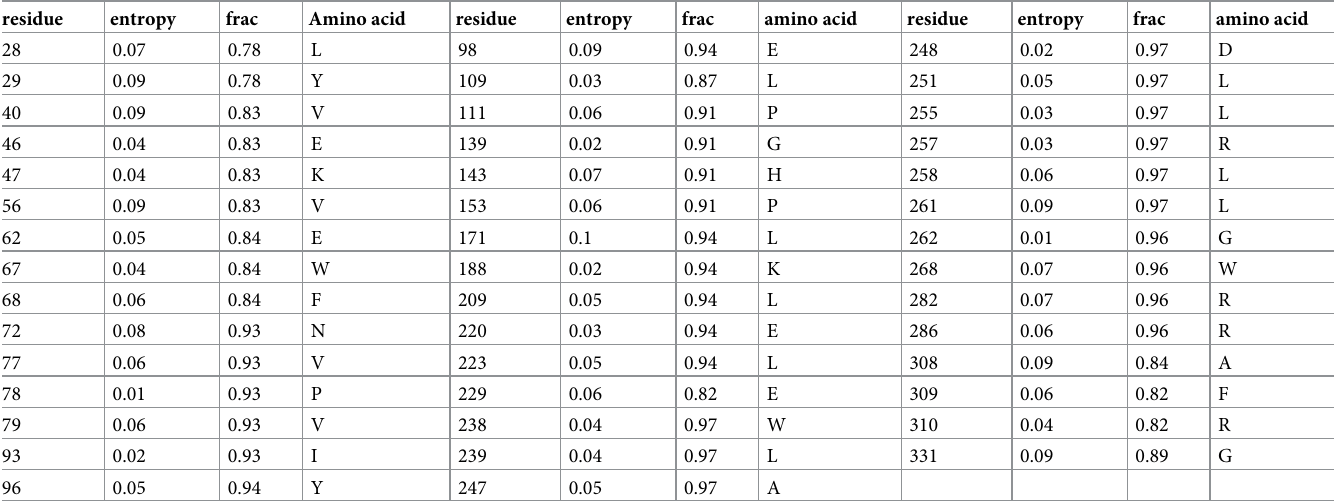
Table 4. Entropy analysis of the GDAP1 subfamily. Shown are the positions (human GDAP1 reference sequence numbering) with the lowest entropy (S < 0.1).